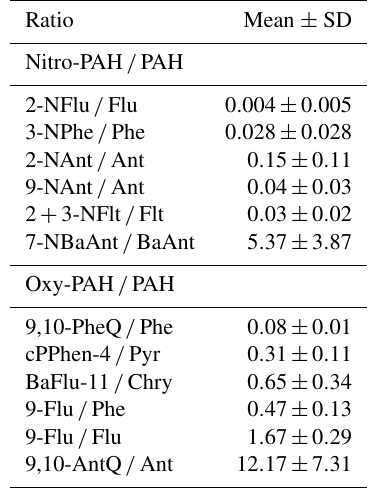
Table 2. Ratios of individual oxy- and nitro-PAHs to their corre- sponding parent PAHs (G + P) in Longyearbyen power plant; aver- ages of individual ratio values ( n = 6) with standard deviation are